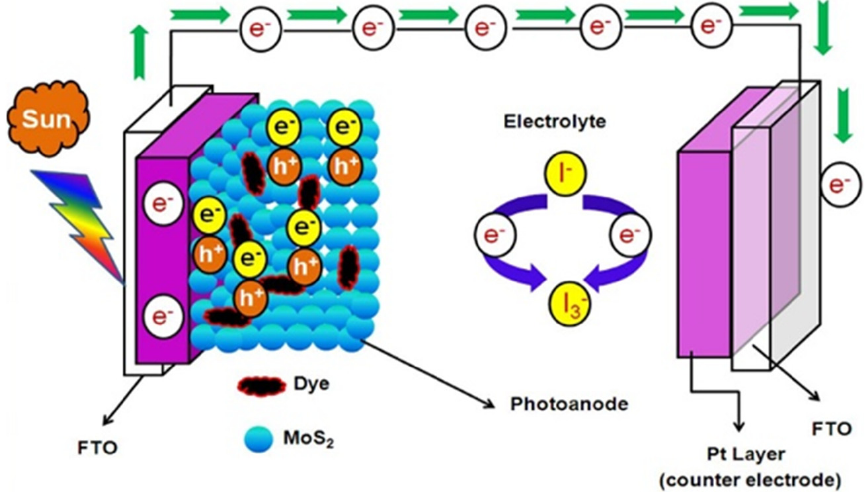
Figure 6. The schematic of MoS 2 /graphene nanocomposite-based photoanode for dye-sensitized solar cells (DSSCs). Reprinted (adapted) with permission from Reference [131], Copyright (2020), Else- vier.